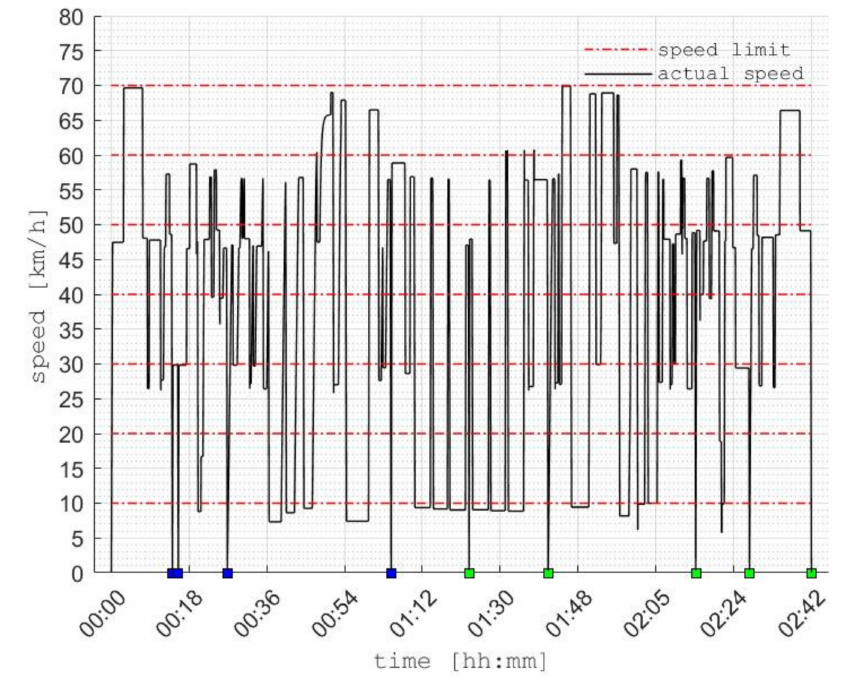
Figure 7. Speed profile.